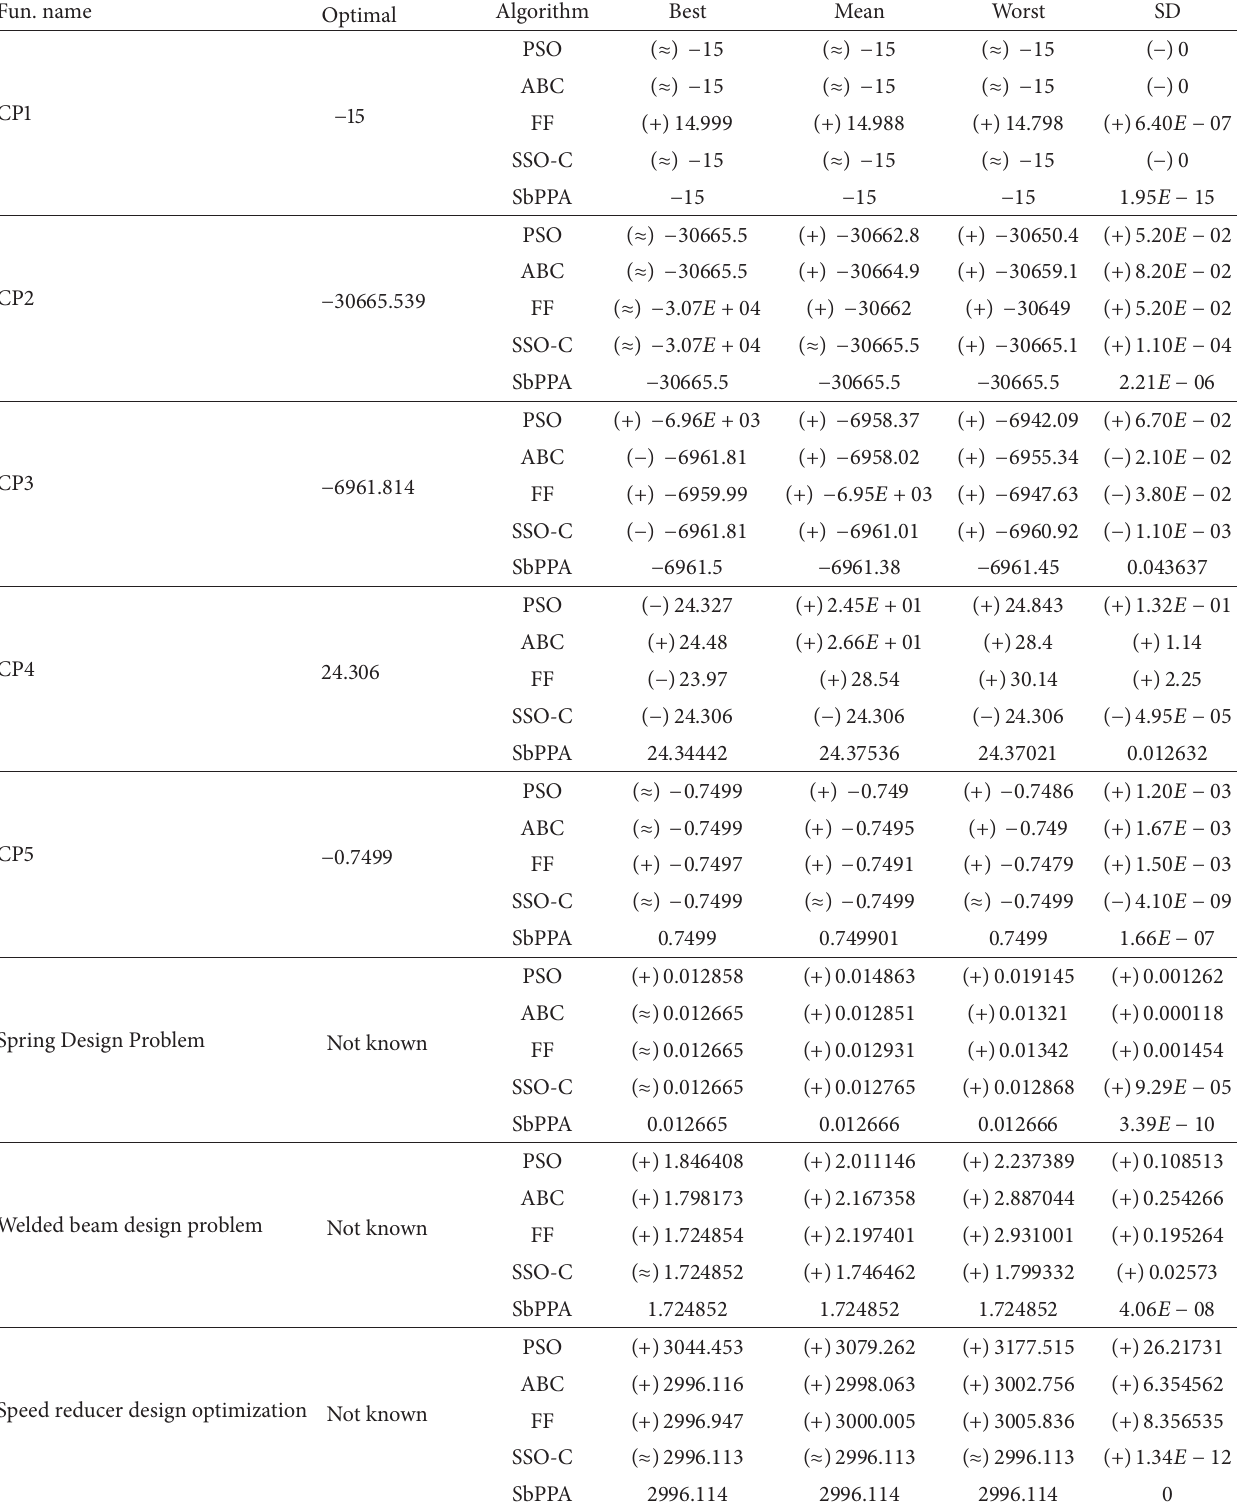
Table 7: Results obtained by SbPPA, PSO, ABC, FF, and SSO-C. All problems in this table are standard constrained optimization problems. Fun.